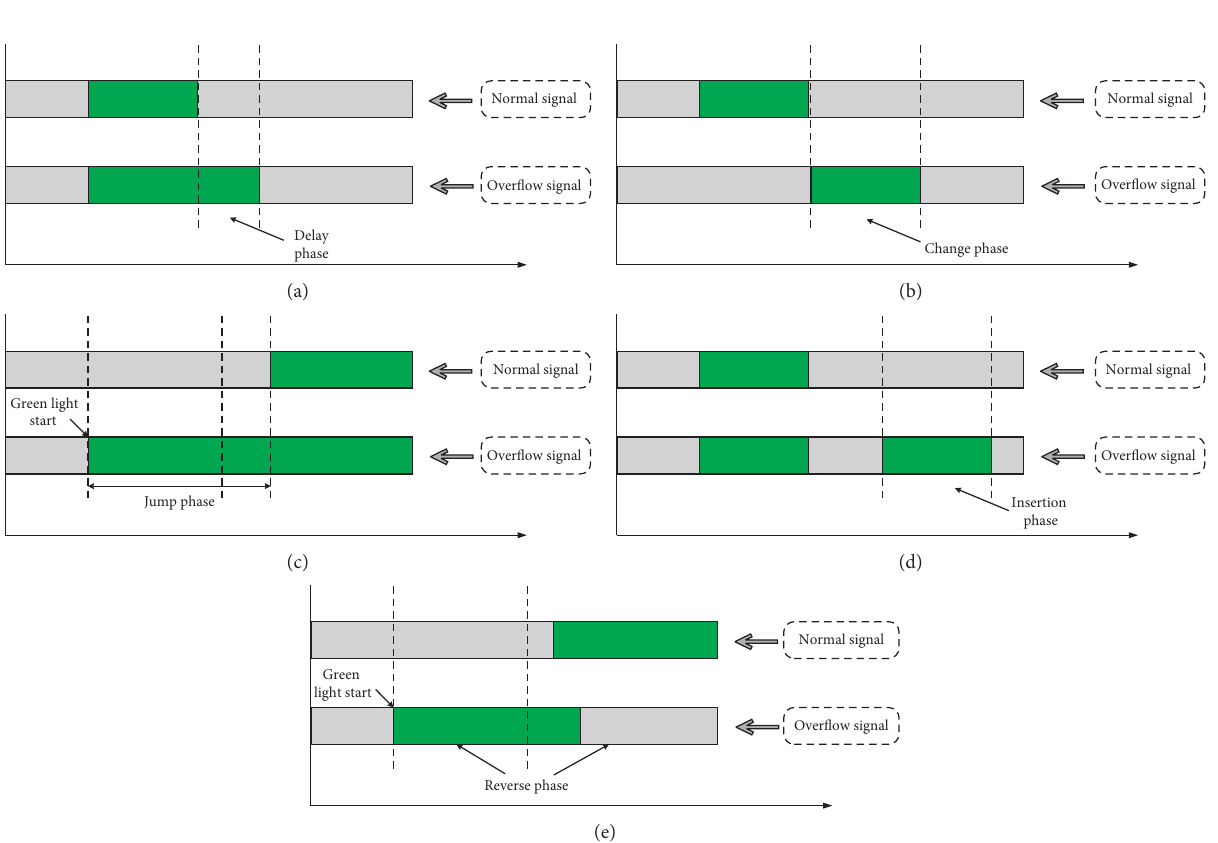
Figure 7: Overflow control strategy structure. (a) Delay phase. (b) Change phase. (c) Jump phase. (d) Insertion phase. (e) Reverse phase.